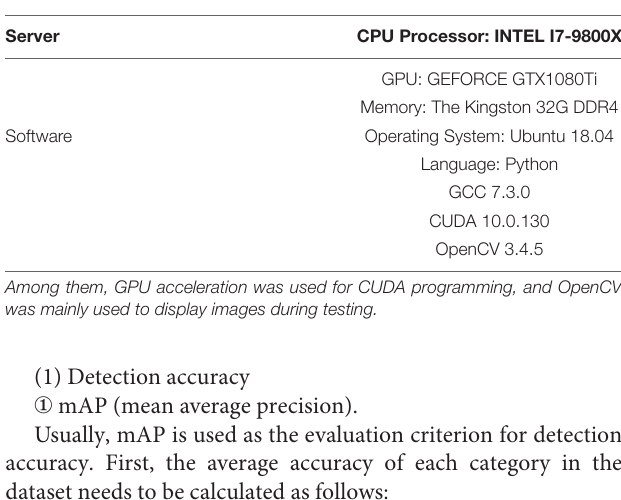
TABLE 2 | Configuration of an experimental platform. TABLE 3 | Comparison of training results of six models.